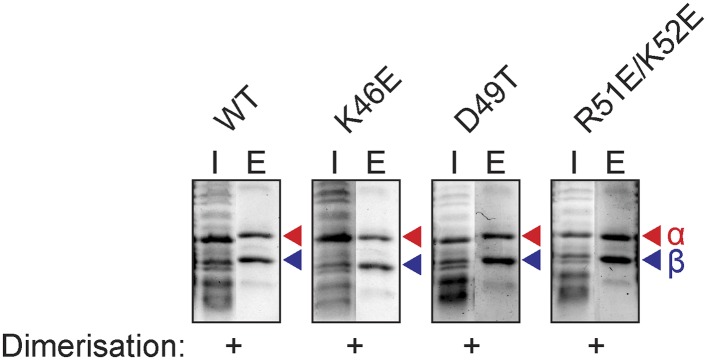
Additional mutants of the N-terminal tip of α-helix 3 of TFEα and their effect on dimerization with TFEβNi-affinity co-purification assays conducted for TFEβ-His co-expressed with TFEα (WT), TFEα K46E, TFEα D49T, or TFEα R51E/K52E. Red and blue triangles indicate the position of the respective mutant variants of TFEα and TFEβ-His, respectively.